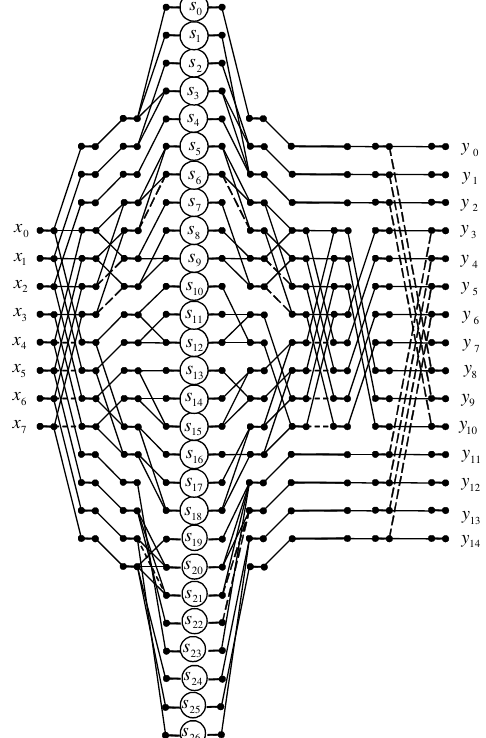
Figure 7. The signal flow graph of the proposed algorithm for computation of 8-point linear